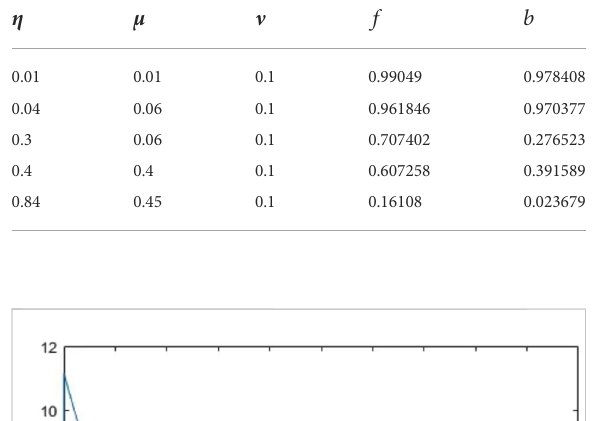
TABLE 2 Example for the second joint PNS attack.